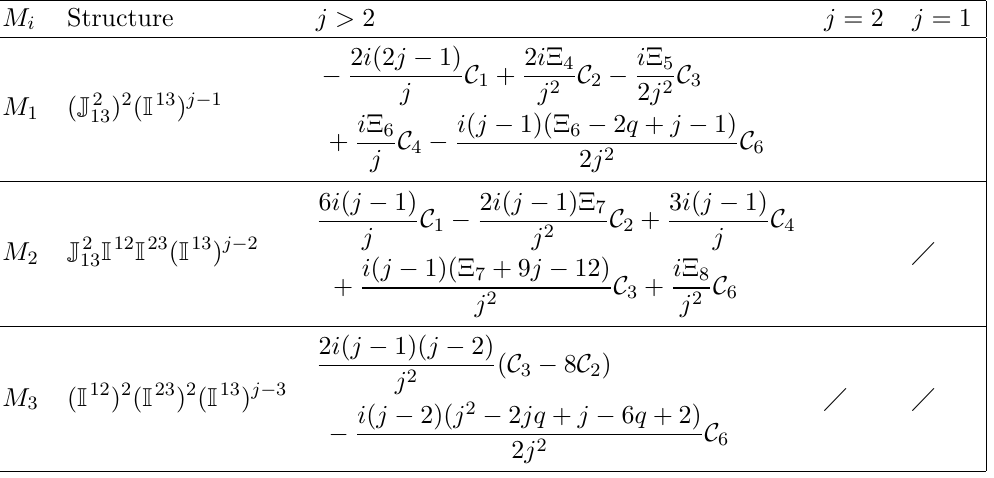
Table 22 . Expansion of the supersymmetric correlator in the component has spin (0 ; 1 ( j 1)) and QO has spin ( 1 ( j + 1) ; 0). The unbarred entry in the j = 1 column can 2 2 (cid:0) be obtained by setting = 0. Note that this table is identical to table 21. C 6